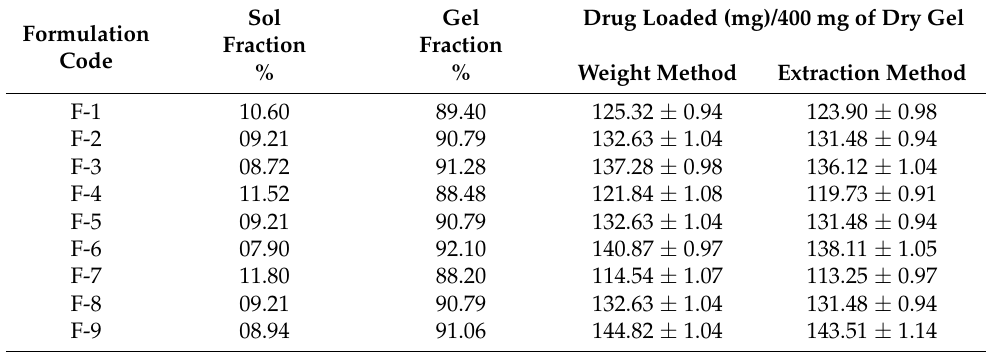
Table 2. Sol–gel analysis and drug loading of CS/ β -CDcPAa